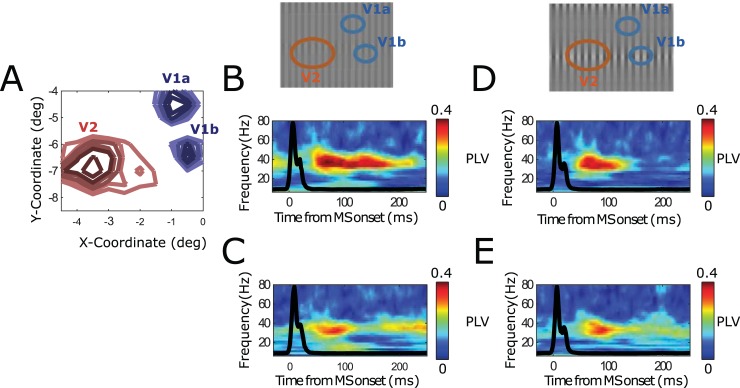
Illustration of differential synchronization of 2 V1 locations to 1 V2 location (from 1 session, Monkey M1).(A) The RF locations of the 2 V1 locations (V1a, V1b) and V2 location. (B–C) Stimulus grating had uniform contrast. (B) V1a-V2 MS-triggered TFR PLV. Squared dashed box indicates the sustained period. (C) Same as panel B, but for V1b-V2 MS-triggered TFR PLV. (D–E) Stimulus had varying spatial contrast. (D) V1a-V2 MS-triggered TFR PLV. (E) Same as panel D, but for V1b-V2 MS-triggered TFR PLV. MS, microsaccade; PLV, phase-locking value; RF, receptive field; TFR, time-frequency representation.